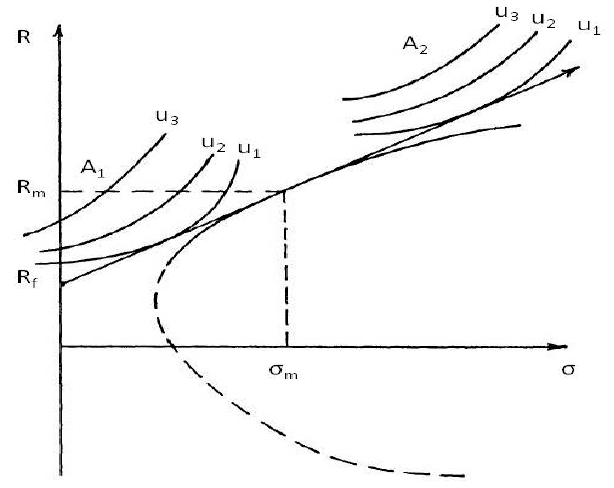
Figure 2. CML and investment choices depending on different risk aversion.